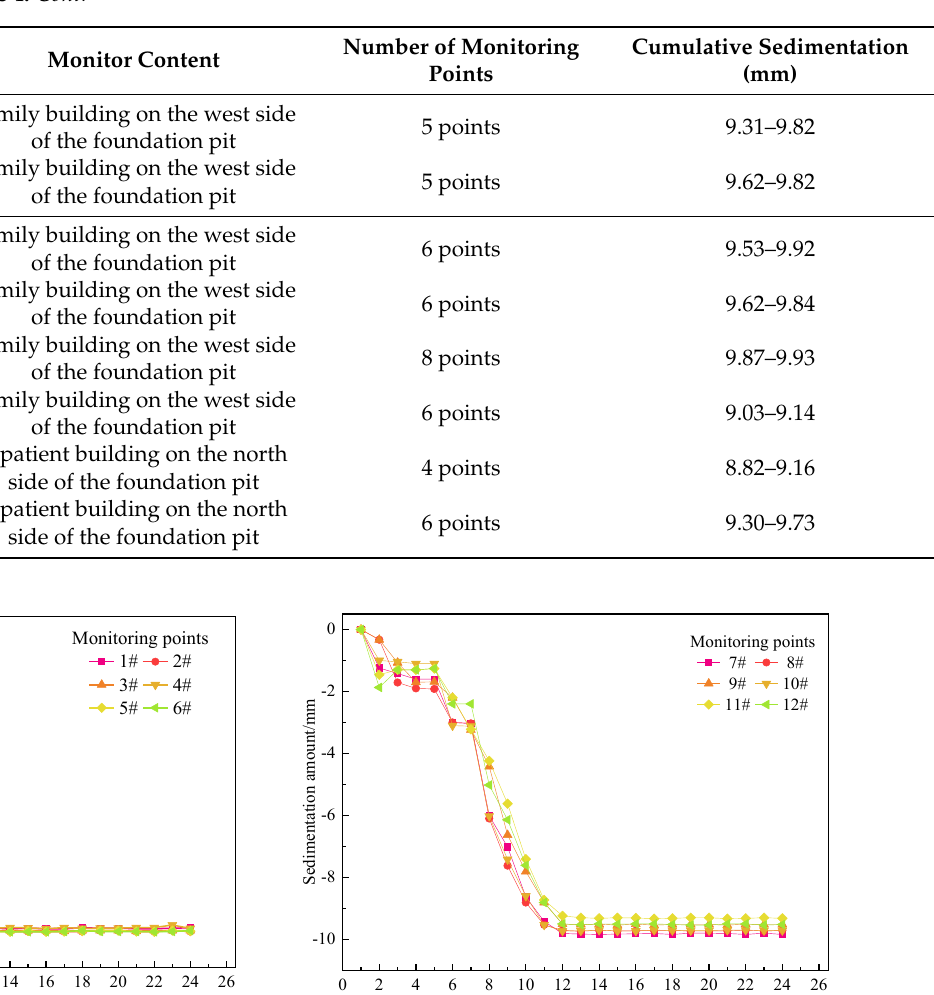
Table 4. Cumulative settlement by building. Table 4. Cont.